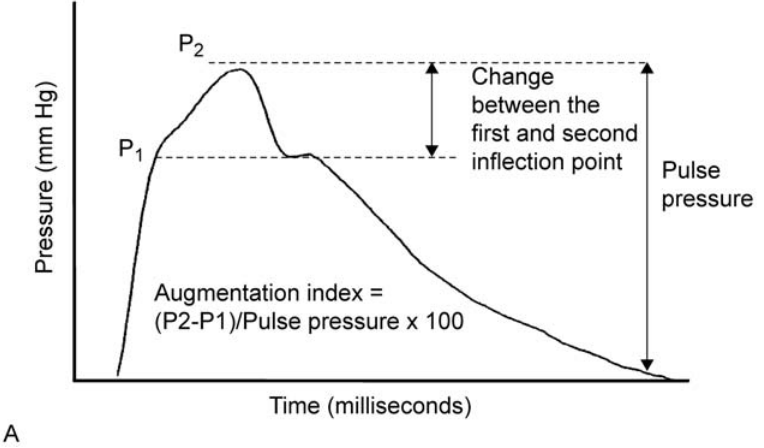
Figure 2. The central (aortic) pulse waveform, represented schematically. A. Typical ascending aortic pulse waveform, showing two systolic peaks (P1 and P2). Augmentation index (AIx) is calculated as the difference between P2 and P1, expressed as percentage of pulse pressure. In hypertensive disorders arterial wall stiffness is increased; the arterial pulse wave travels faster, so the reflected wave reaches the advancing wave in systole, resulting in greater augmentation of the systolic peak. P1=the first inflection point; P2=the second inflection point.